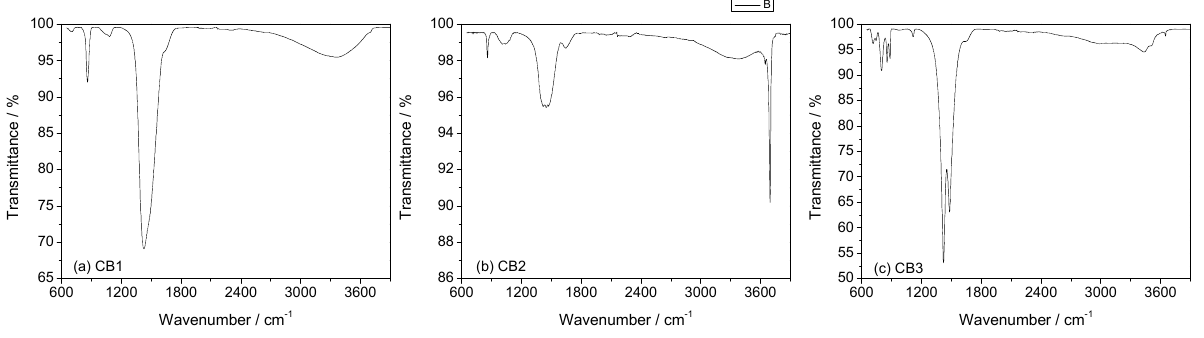
Figure 8. XRD patterns of ( a ) CB1, ( b ) CB2, and ( c ) CB3 products under atmospheric pressure. Figure 9. FTIR spectra of ( a ) CB1, ( b ) CB2, and ( c ) CB3 products under atmospheric pressure.